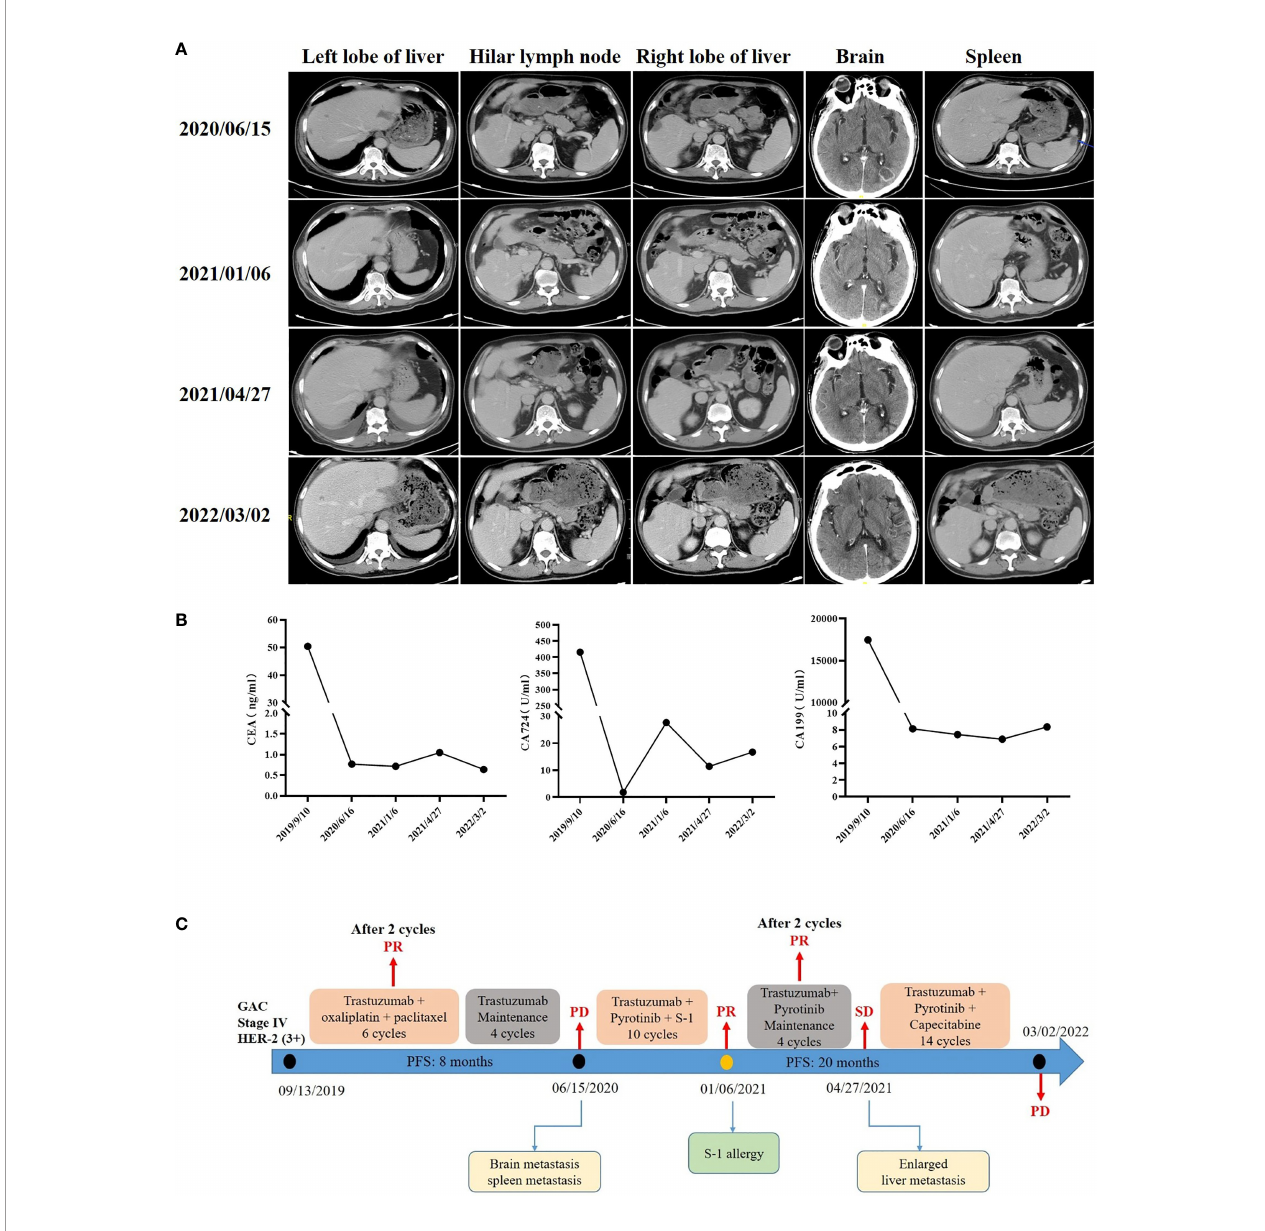
FIGURE 2 | Computed tomography during treatment (A) , blood tumor antigen changes (B) , and timeline of the clinical course in this patient (C)